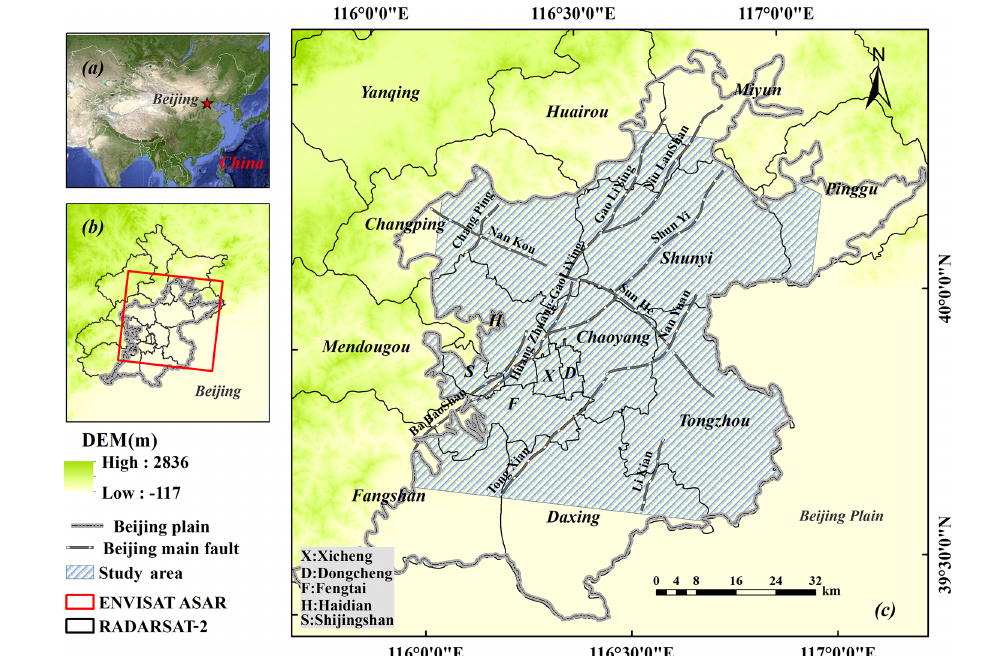
Figure 1. Geographical location of the study